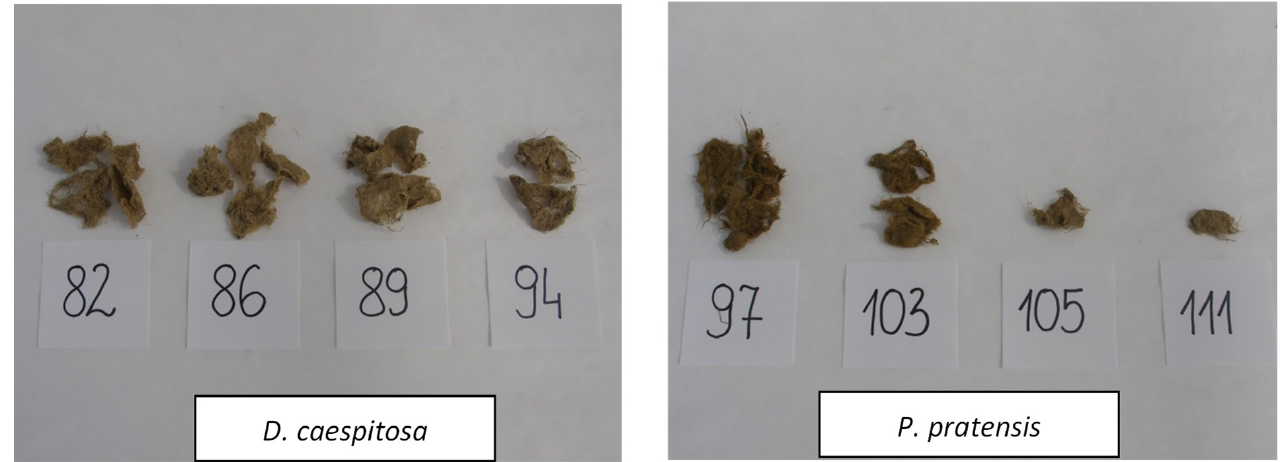
Figure 4. Grass roots. Pot number/Zn level: 82/0, 86/Zn1, 89/Zn2, 94/Zn3; 97/0, 103/Zn1, 105/Zn2, and 111/Zn3.